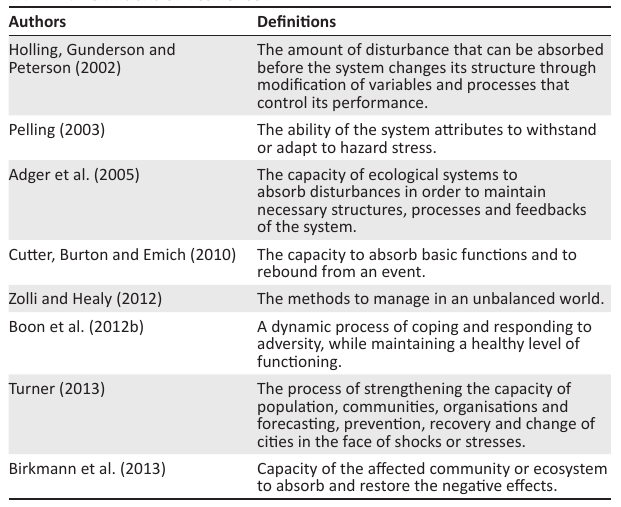
TABLE 1: Definitions of